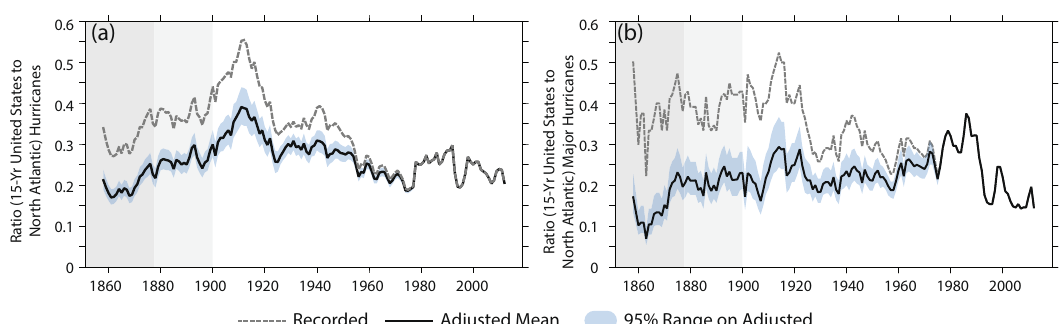
Fig. 3 Ratio of USA hurricane strikes to basin-wide hurricane frequency. Ratio of the 15-year running count of United States of America (USA) strikes and 15-year running count of basin-wide frequency for hurricanes ( a ) and major hurricanes ( b ). Dotted gray line shows the values based on the recorded version 2 of the North Atlantic Hurricane Database (HURDAT2, ref. 33 ) frequency, while the thick solid line shows the value based on the HURDAT2 recorded USA strikes and the adjusted basin-wide frequencies; blue shading shows the 95% range on the ratio based on a Bootstrap sampling of the adjustment values. Gray background shading is as in Fig. 1, and highlights times where we have reduced con fi dence in the basin-wide and USA strike frequency estimates even after adjusting for likely